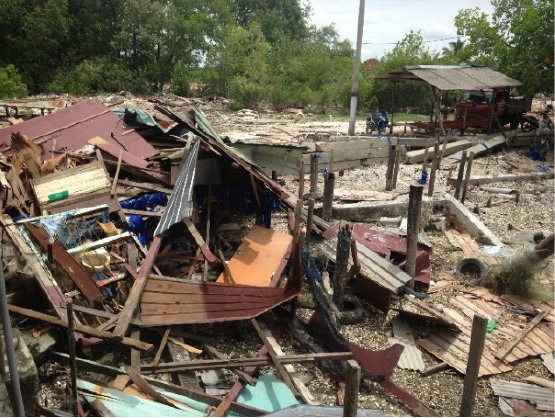
Figure 9 Land loss impacts on erosion phenomena in Bagan Pasir. Figure 9. Land loss impacts on erosion phenomena in Bagan